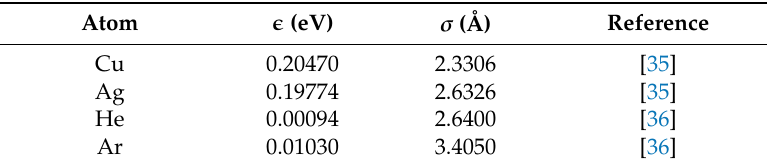
Table 1. Pair potential parameter (12-6 Lennard-Jones).